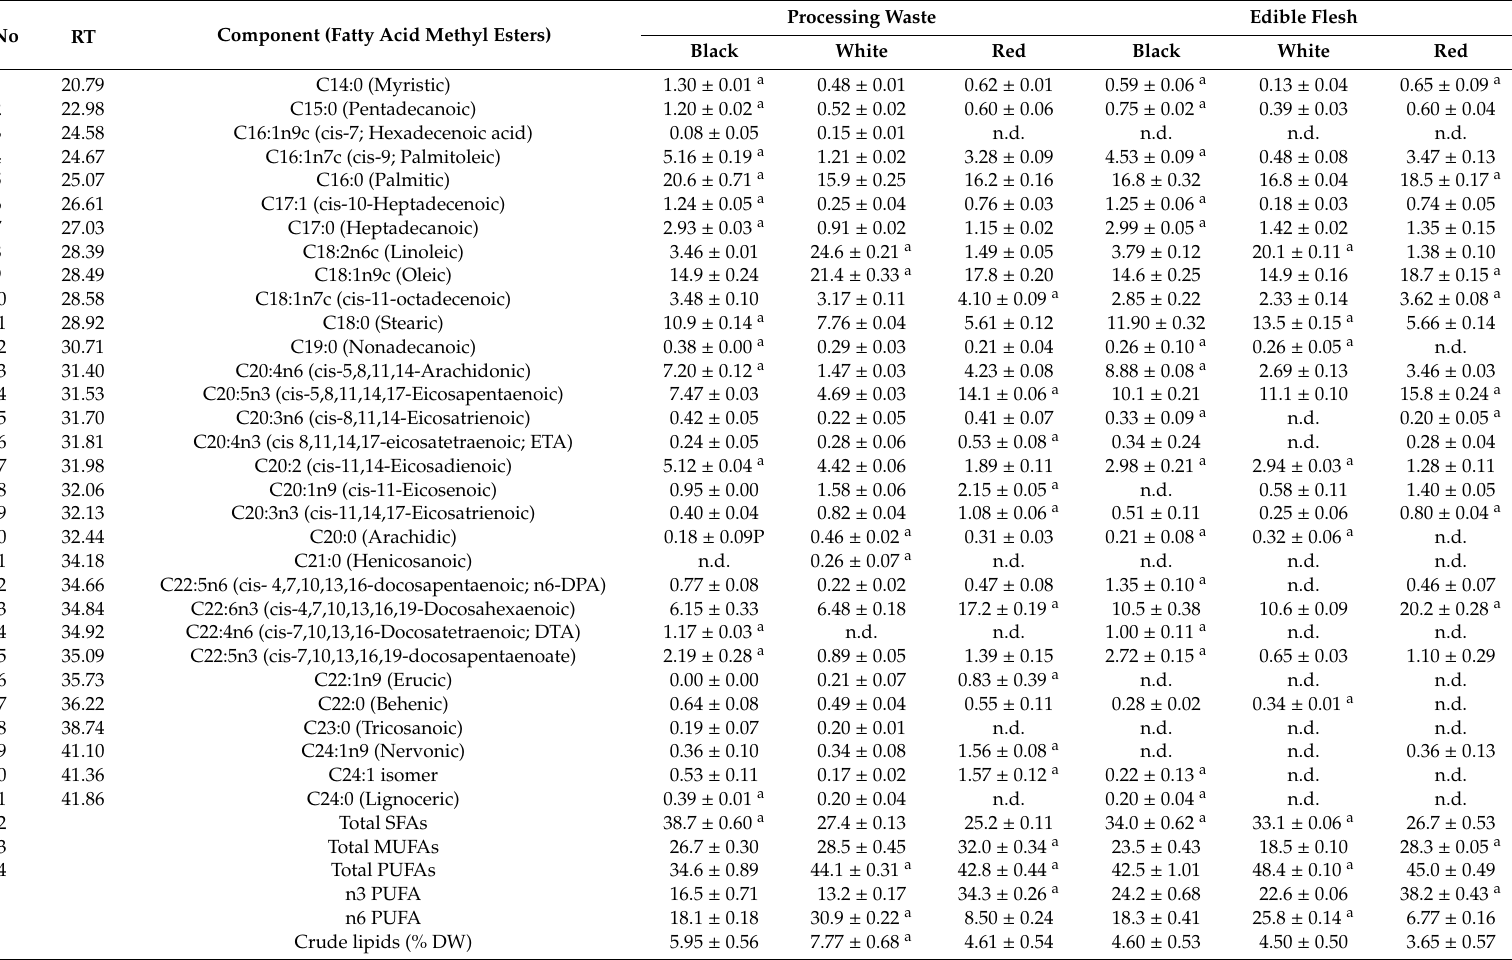
Table 4. The fatty acids composition of waste and edible flesh of three shrimp